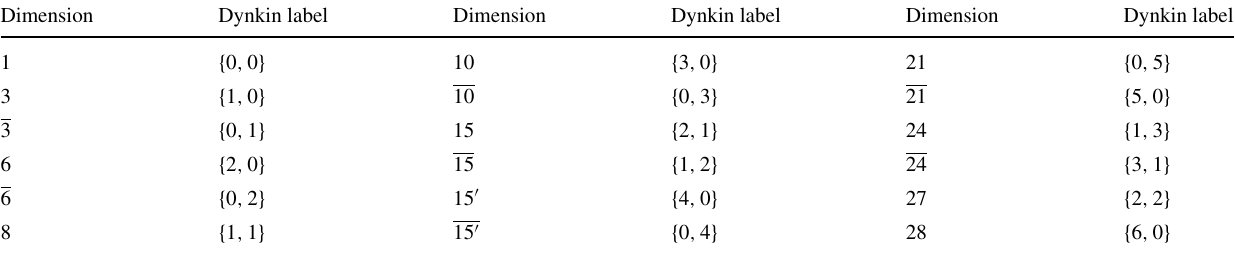
Table 58 Dynkin labels corresponding to a few low dimensional representations of SU ( 3 ) Dimension